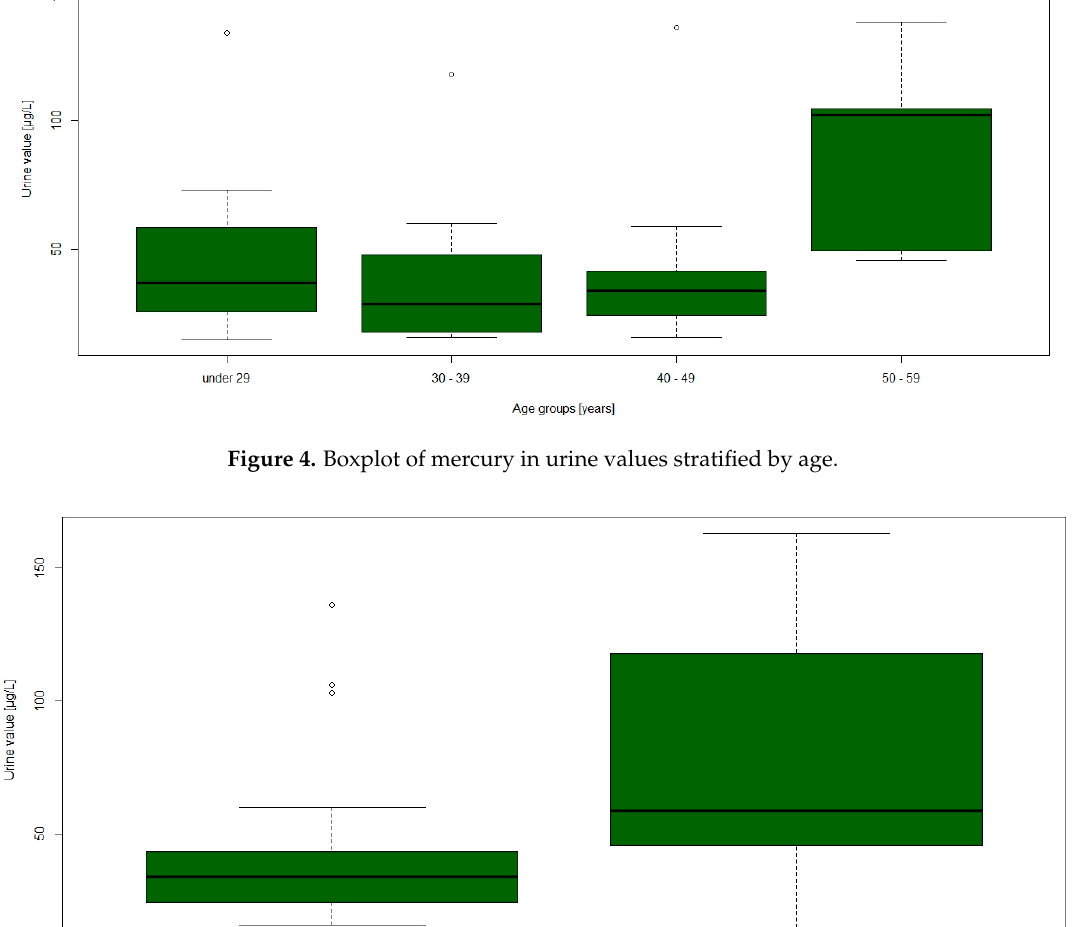
Figure 3. Frequencies of medical score symptoms and positive test results within subgroup ( n = 36).